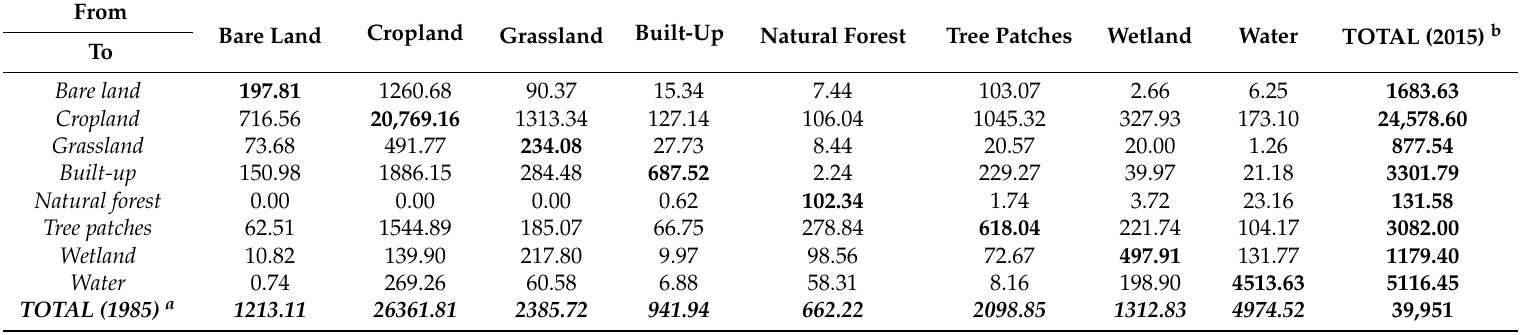
Table 7. Summary of LULC conversion matrix in ha from 1985 to 2015. a Row total sums the amount of land for each LULC types of the initial study year (1985); b column total sums the amount of land Table 2015. The bold diagonal values represent the area of each class that remains unchanged while the o ff diagonal values represent the change in